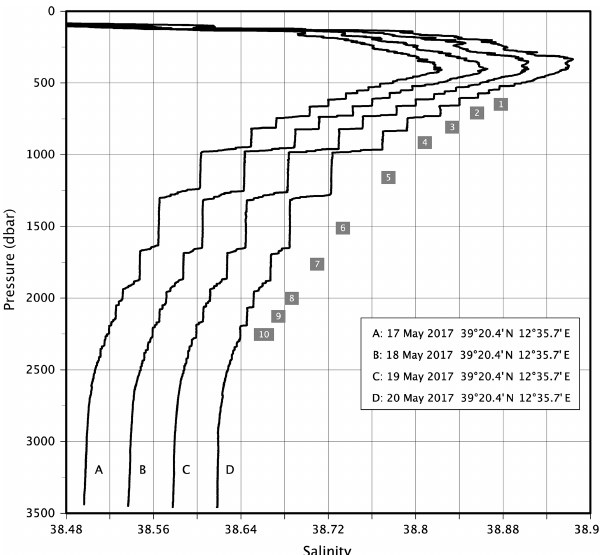
Figure 3. Sequence of daily salinity profiles observed in the cen- tral Tyrrhenian Sea during the cruise PEACETIME over the whole water column. The salinity scale is correct for profile A, and each subsequent profile is offset by 0.04. The layer numbering in Table 3 is indicated by grey boxes at average layer